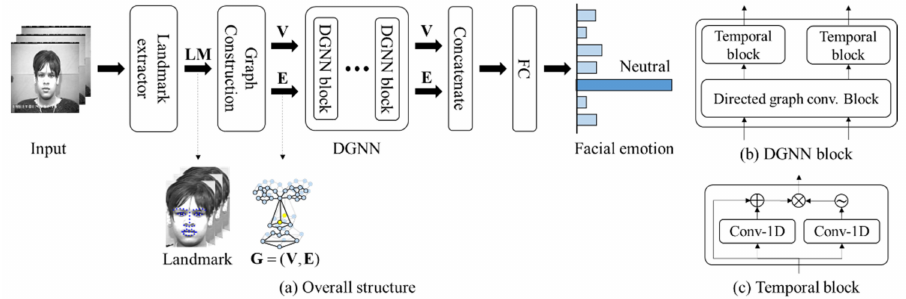
Figure 2. ( a ) Overview of the proposed method, ( b ) improved directed graph neural network (DGNN) block, and ( c ) gated linear unit (GLU). LM, V , E , G , and FC indicate landmark, vertex, edge, graph, and fully-connected layer, respectively.